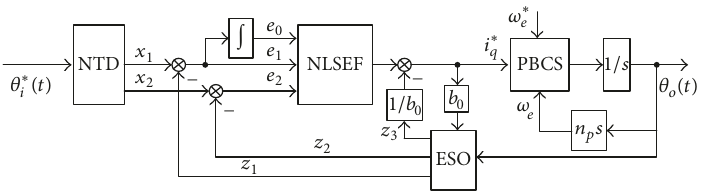
Figure 4: Diagram of the ADRC-PBC